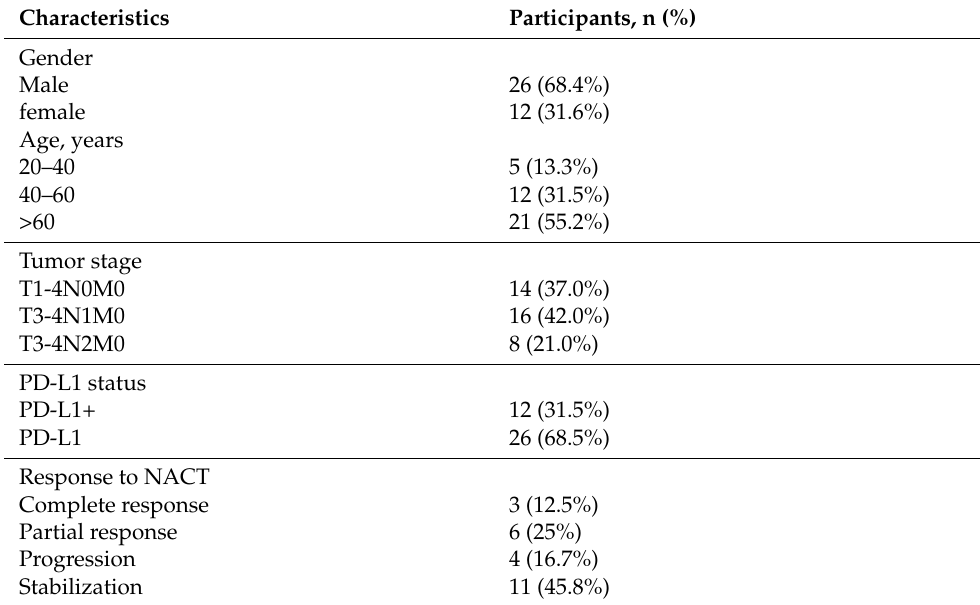
Table 8. Clinical characterization of GC